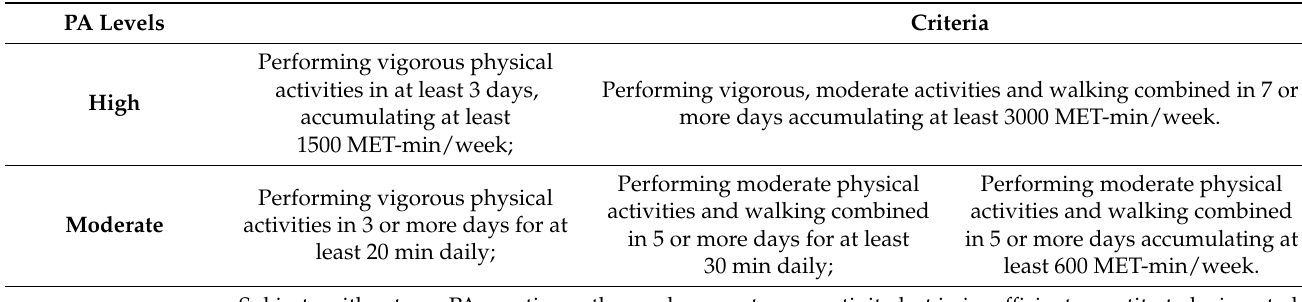
Table 1. International Physical Activity Questionnaire (IPAQ) classification